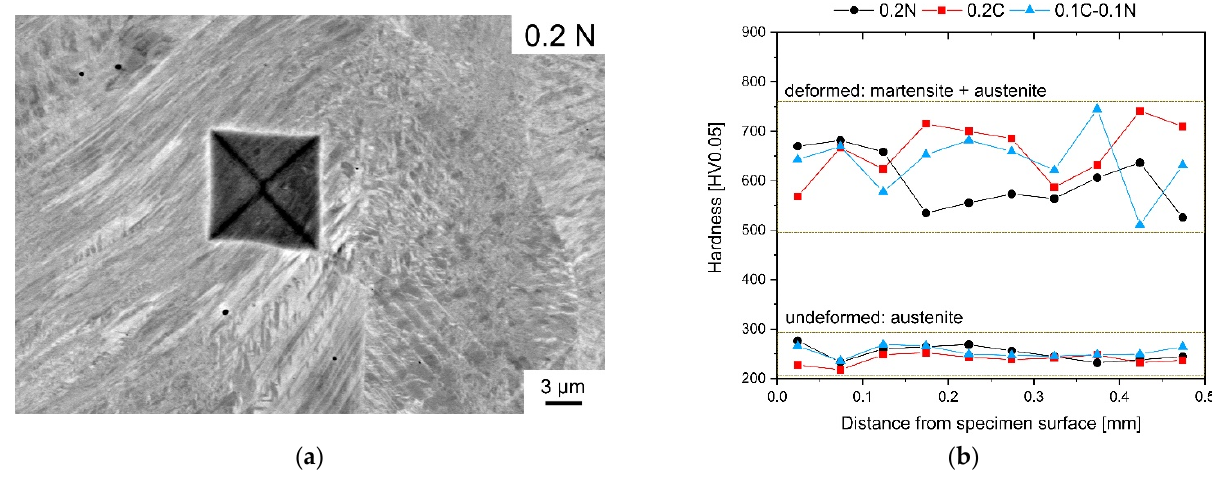
Figure 6. Microhardness profiles of the present steels after tensile test at RT: ( a ) SEM image showing a hardness indentation in the deformed microstructure of steel 0.2N and ( b ) hardness profiles taken from the initial undeformed and the deformed state after tensile test.